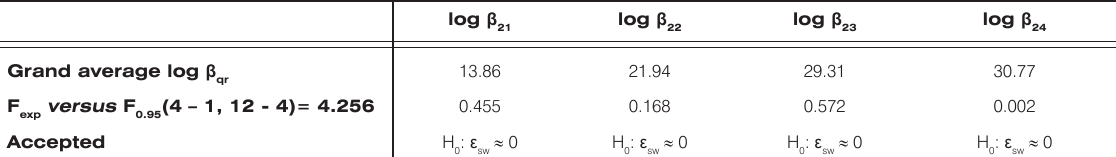
(4 – 1, 12 - 4)= 4.256 0.95